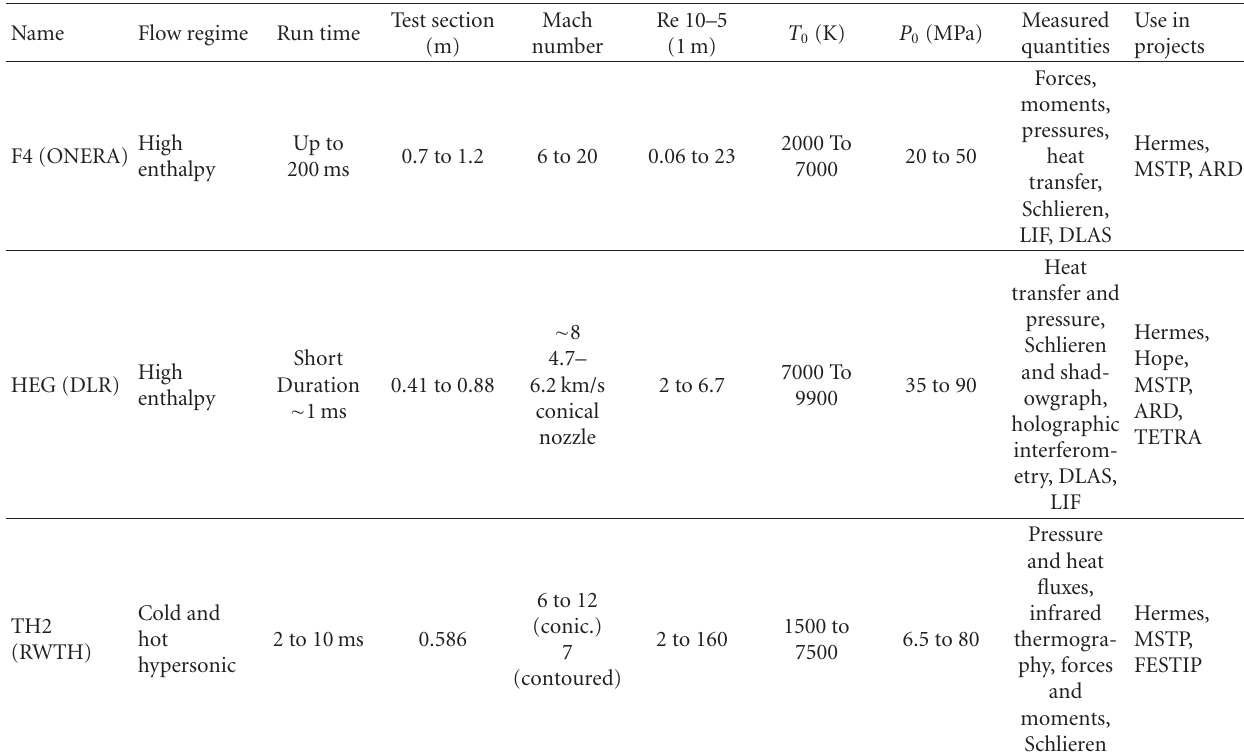
Table 6: Capabilities of some available European installations for investigating chemical kinetics and aerothermodynamics related to Earth